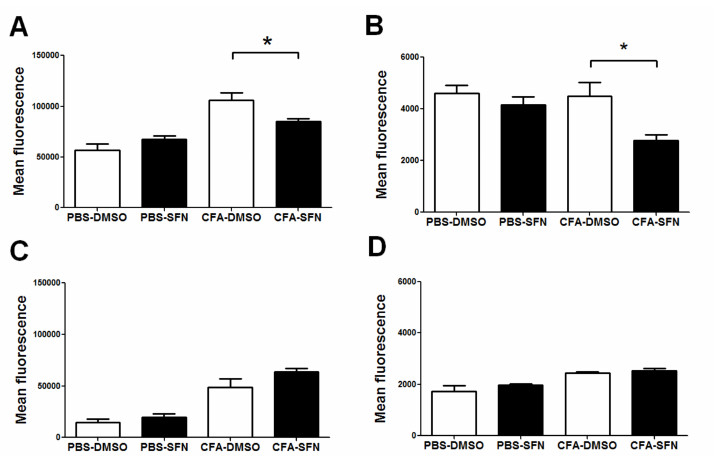
Figure 4. Expression of CD11b and CD62L on synovial fluid monocytes/macrophages and neutrophils. Expression of CD11b ( A ) and CD62L ( B ) on synovial fluid Ly6G + cells. Expression of CD11b ( C ) and CD62L ( D ) on synovial fluid Ly6C + cells. Samples were obtained from ipsilateral (CFA-injected) and contralateral (PBS-injected) joints of vehicle- (open bars) and SFN- (closed bars) treated mice. Data are mean ± SEM. Experiments were performed in four different occasions ( n = 14 animals per group). * p < 0.05.